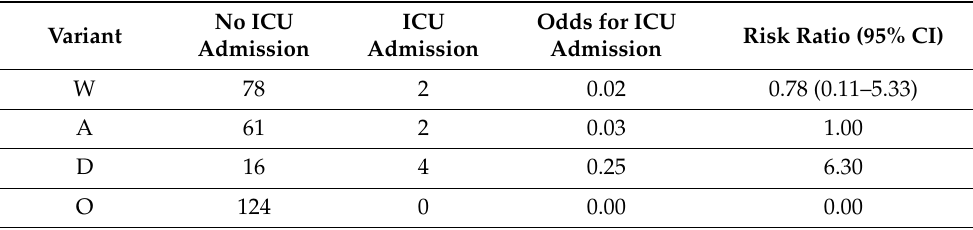
Table 4. Risk ratio estimation and confidence intervals for admission to the step-up unit (ICU) for severe-critical COVID-19 health issues based on the different viral strain that dominated each pandemic